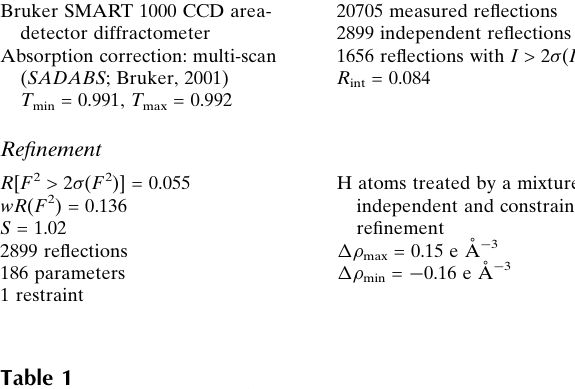
Hydrogen-bond geometry (A˚ , (cid:1)